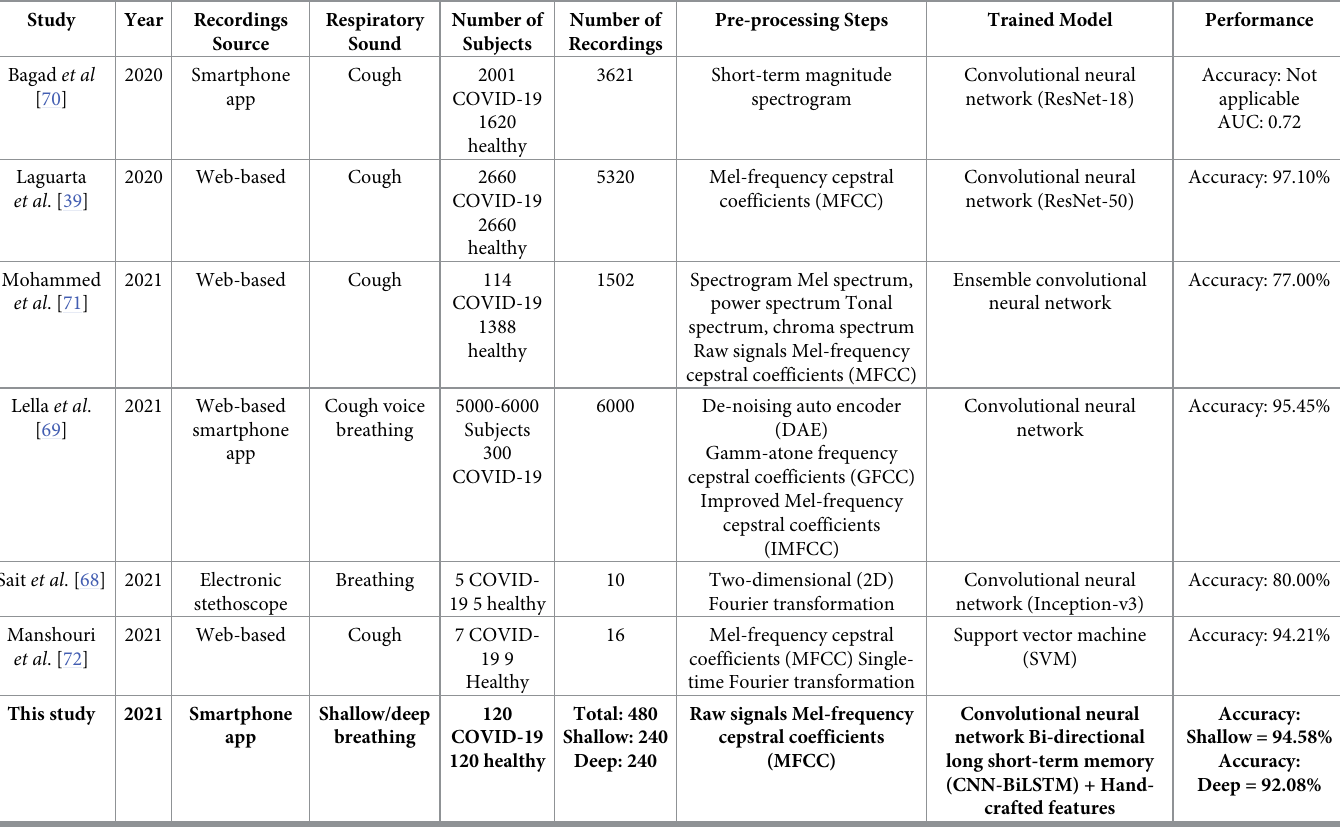
Table 4. Summary table of the current state-of-art works in COVID-19 detection using machine learning and breathing/coughing